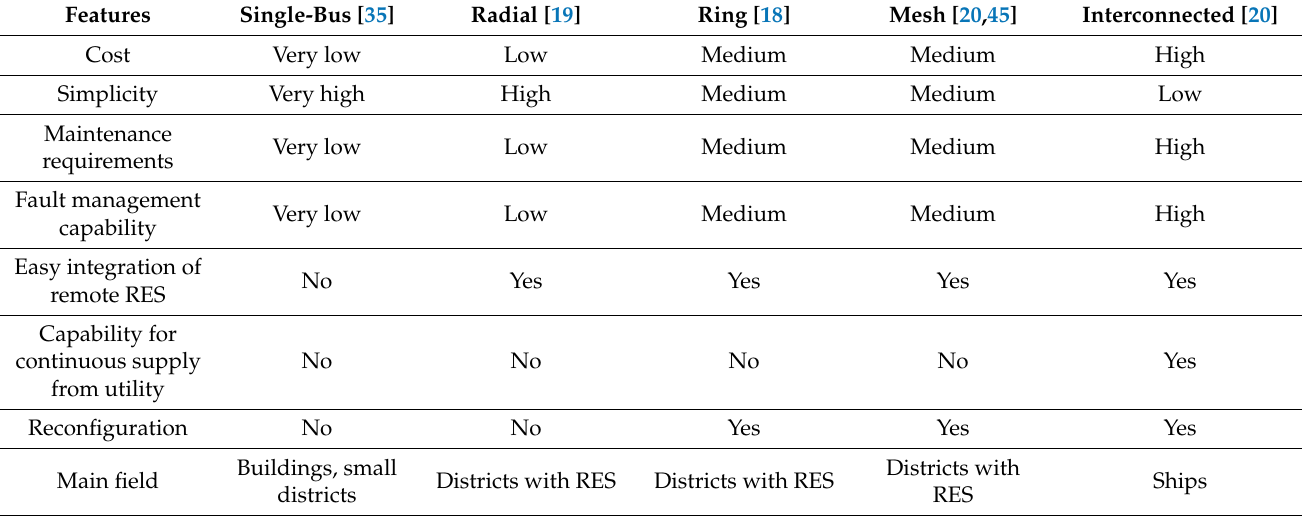
Table 3. Evaluation of topologies (Data from [18–20,35,45])